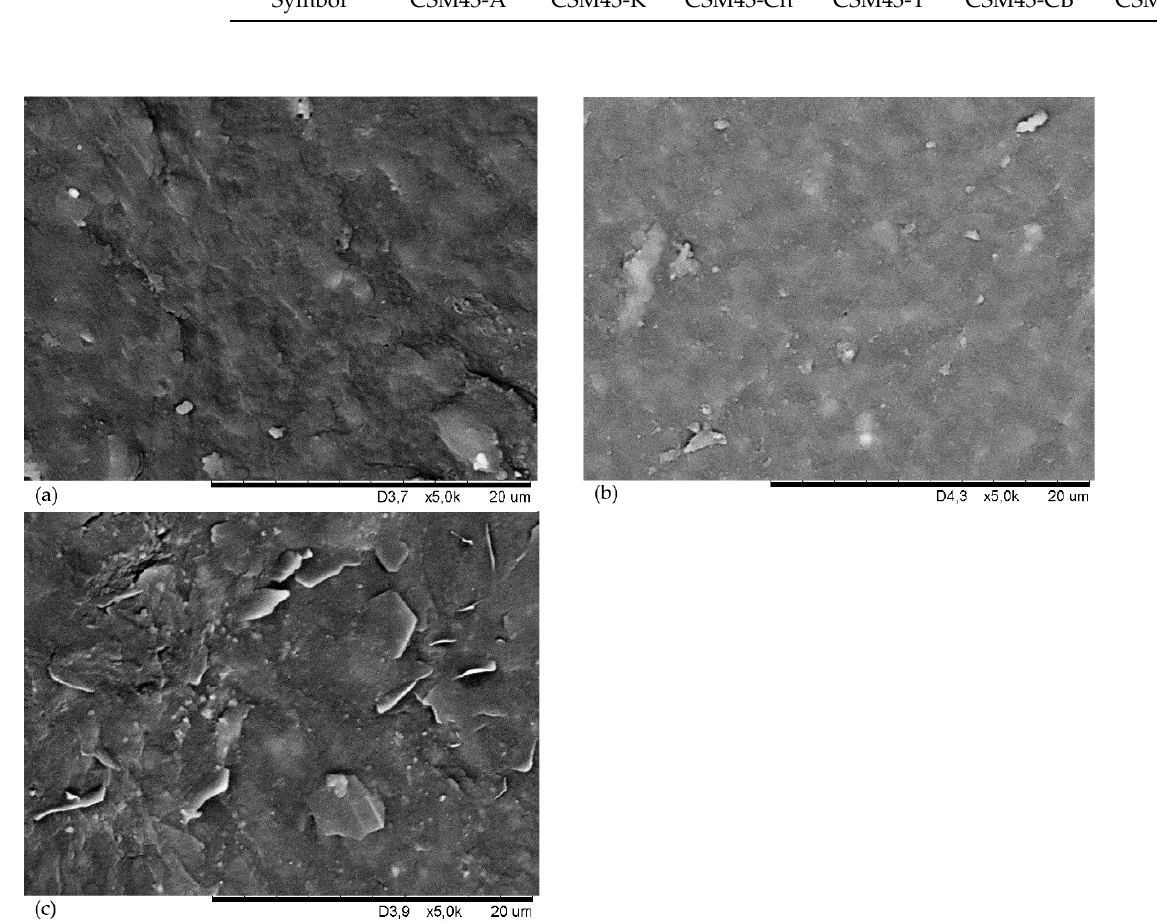
Figure 3. Scanning electron microscope (SEM) images of the vulcanizates containing different types of chlorosulfonate polyethylene: CSM29 ( a ), CSM43 ( b ), CSM35 ( c ).